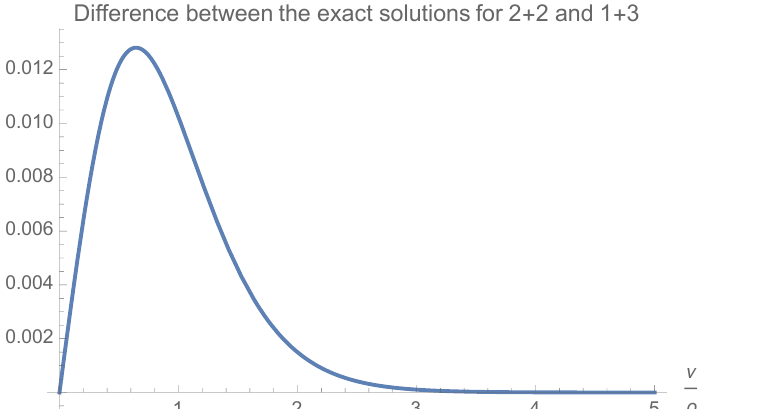
Figure 12 . Absolute value di(cid:11)erence between the two exact solutions for (cid:30) in the case where n = 4 with ( q; l ) = (2 ; 2) and ( q; l ) = (1 ; 3). In both cases, the (cid:12)eld (cid:30) satis(cid:12)es the same two point boundary conditions, also eq. (4.6) tells us that both solutions decay exponentially at the same rate e (cid:0) 3 (cid:23)=(cid:26) . It is not surprising that both solutions will be similar but the 1% discrepancy is a bit